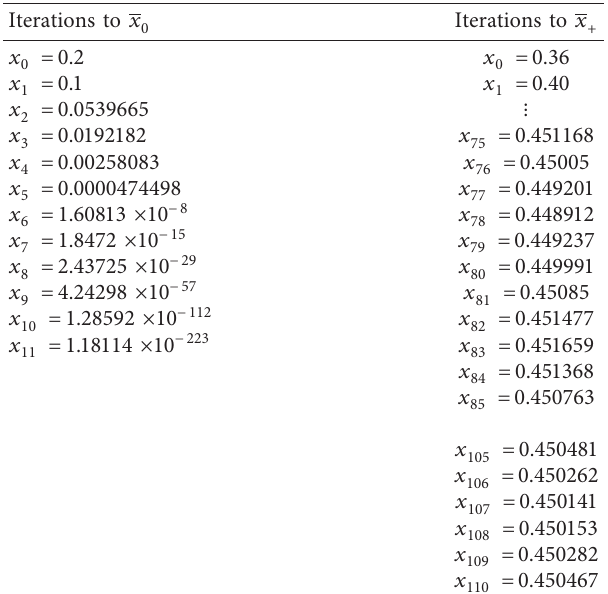
Iterations to x + � 0.36 0